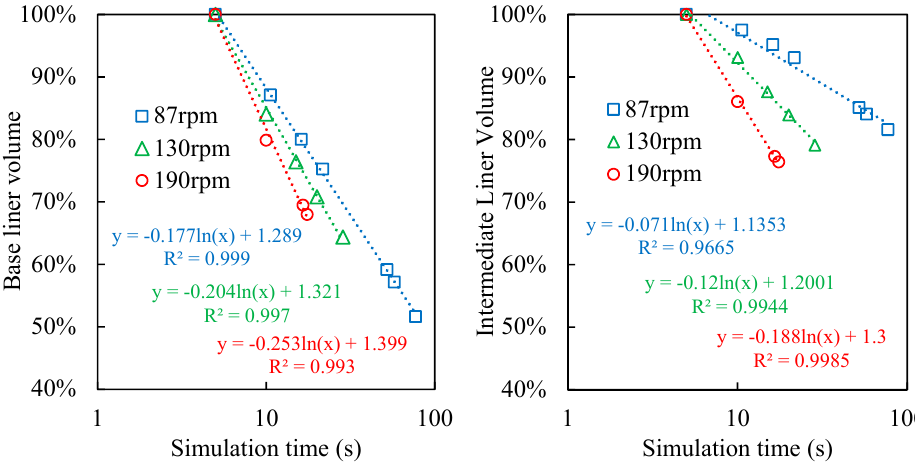
Figure 18. Base and intermediate liner volume during simulation time.